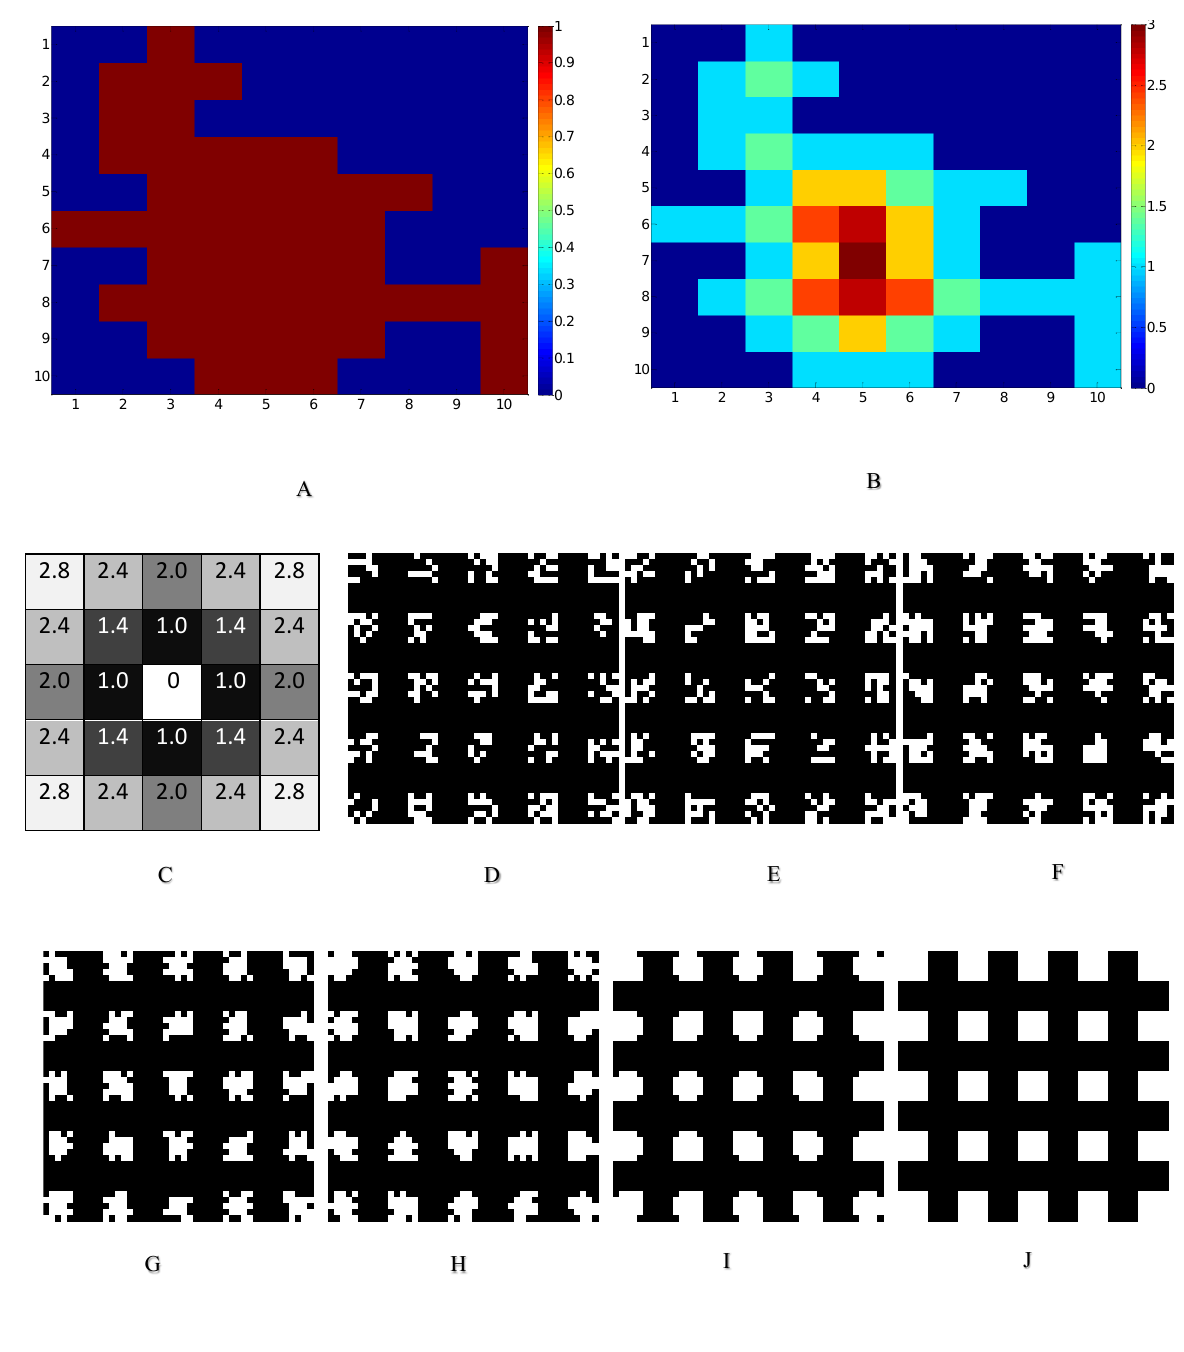
Figure 6 Distance Transform (Qausi) and Test Images